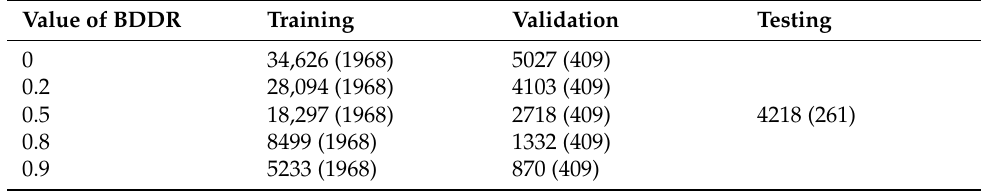
Table 4. The proportion of data set for